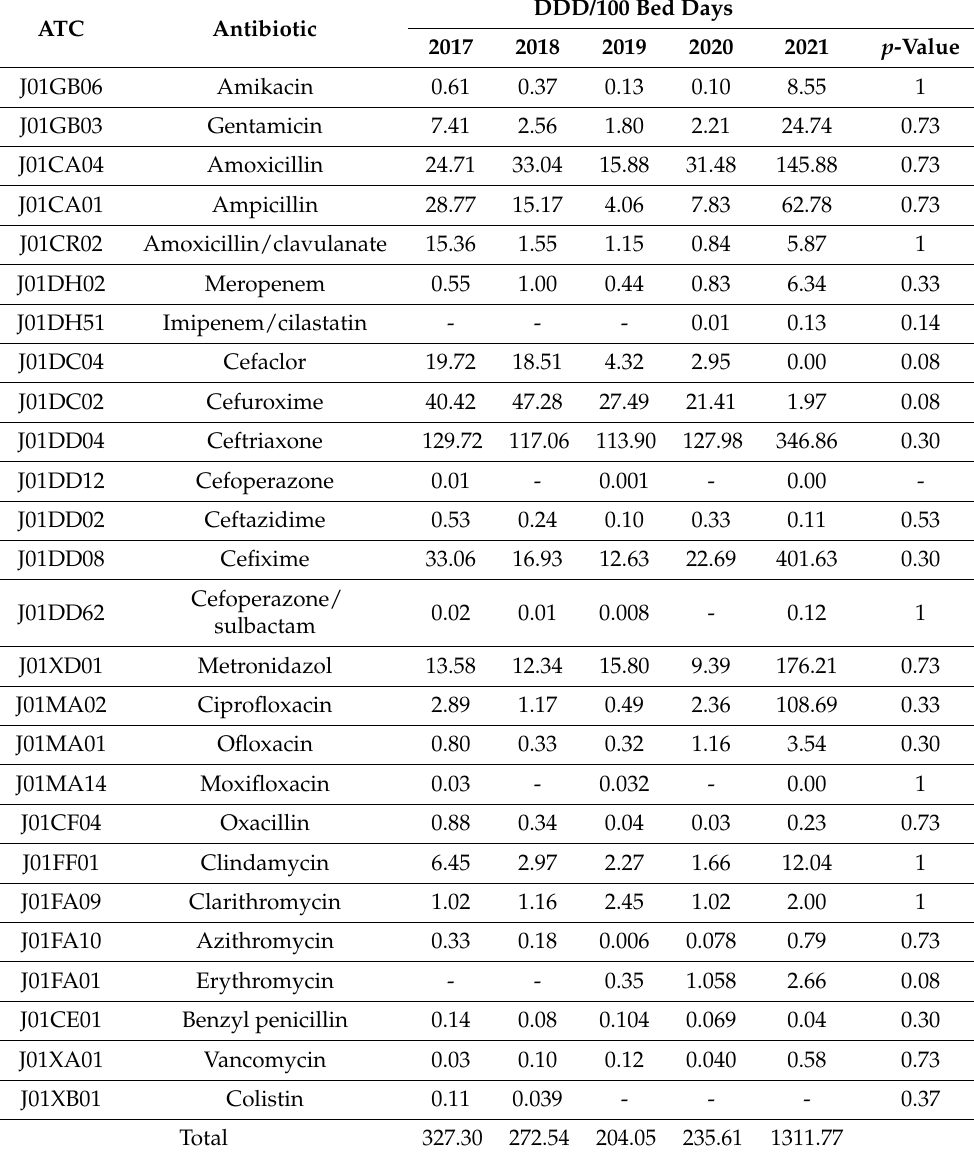
Table 2. Prescribed antibiotics expressed in DDD/100 bed days during the five years evaluated.